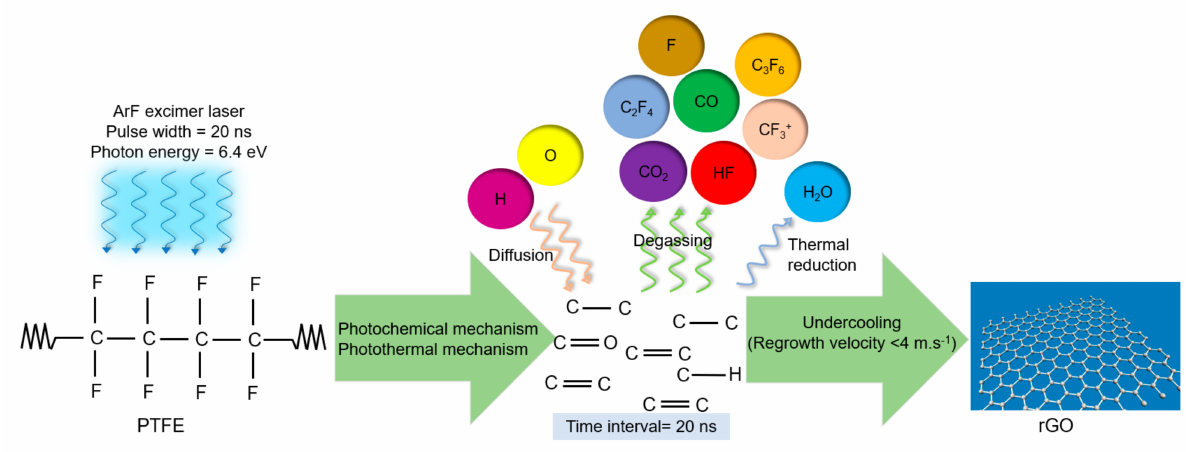
Figure 6. Schematic showing the direct conversion of PTFE into rGO, using ArF-laser